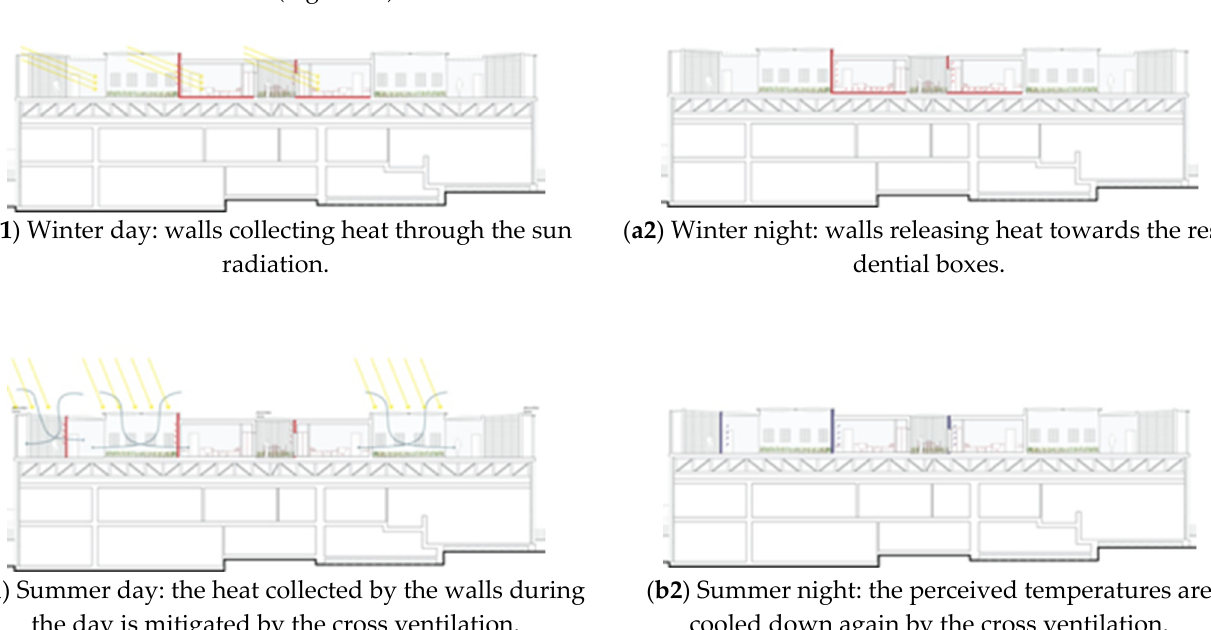
Figure 9. ( a ) Winter behavior of the level; ( b ) Summer behavior of the level; [12].